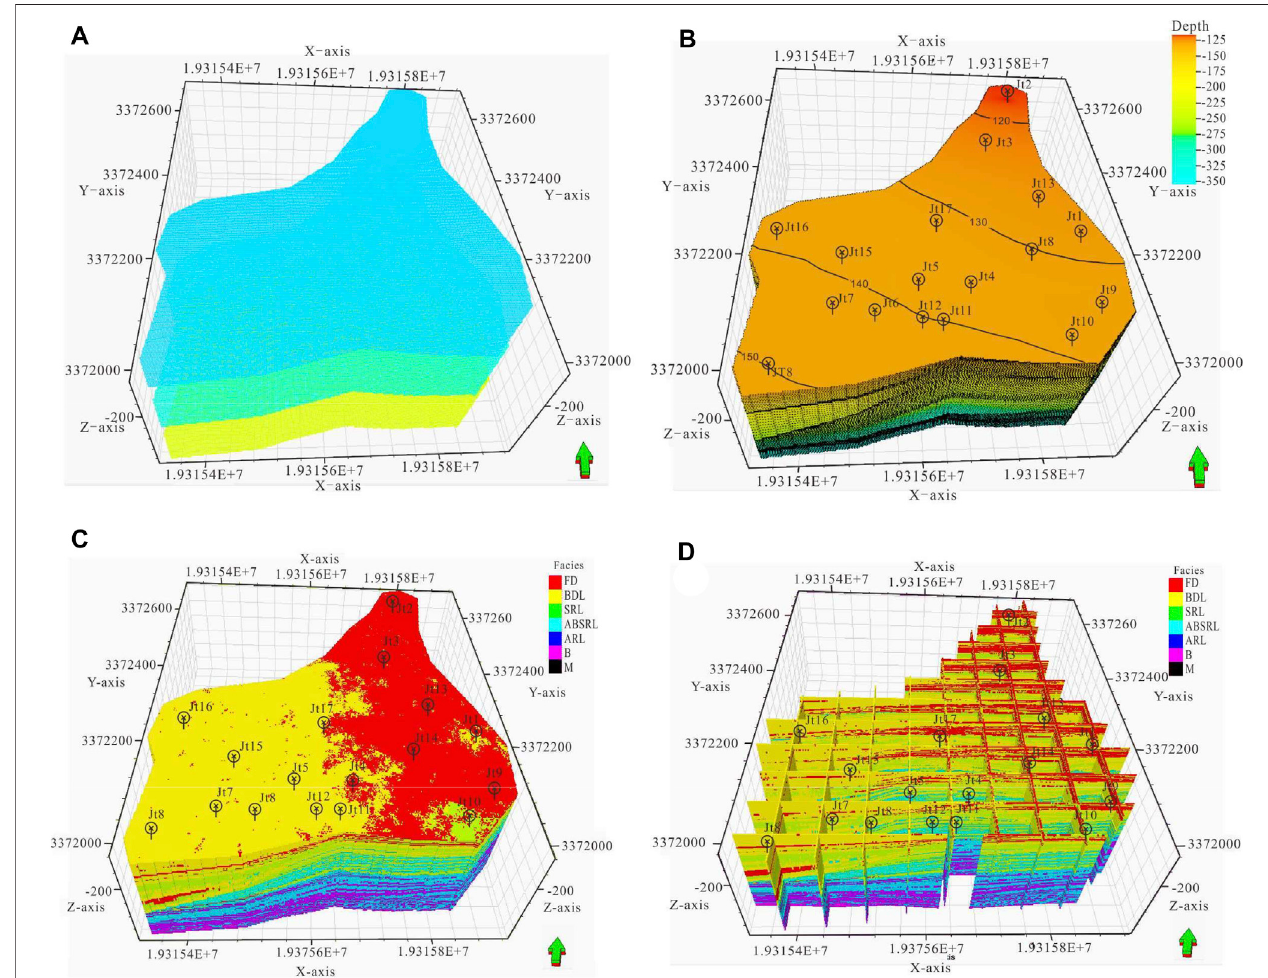
FIGURE9| 3-DstratigraphicstructuralmodeloftypicaloutcropareaofJiantianba. (A) 3-Dgridingmodel; (B) 3-Dstratigraphicstructuralmodel; (C) 3-Dlithological model; (D) palisade 3-D grids display about lithological model.